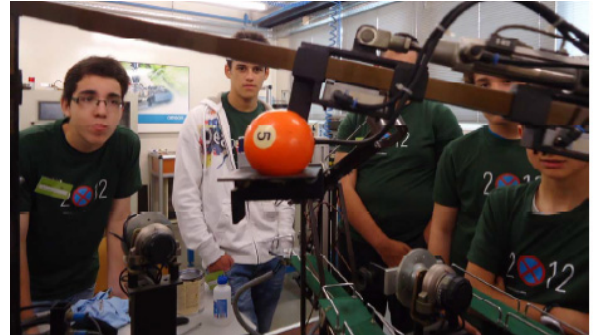
Figure 6. Discovering Mechatronics